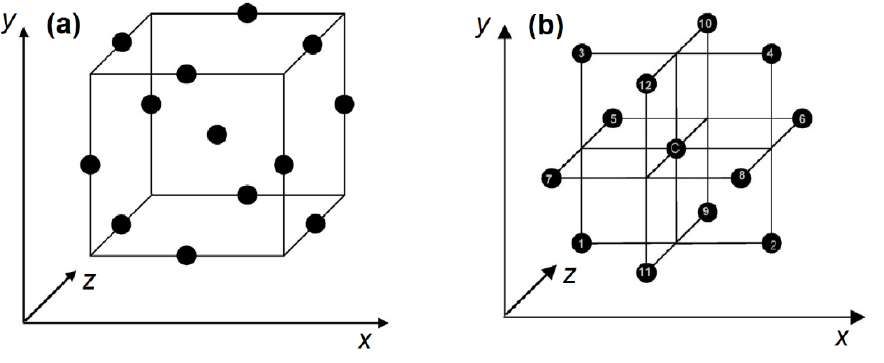
Figure 25. Two different representations for a 3-factorial Box-Behnken design: ( a ) a cube; and ( b ) a three interlocking 2 2 factorial design. Reprinted with permission from [197]. Copyright 2007, Elsevier.